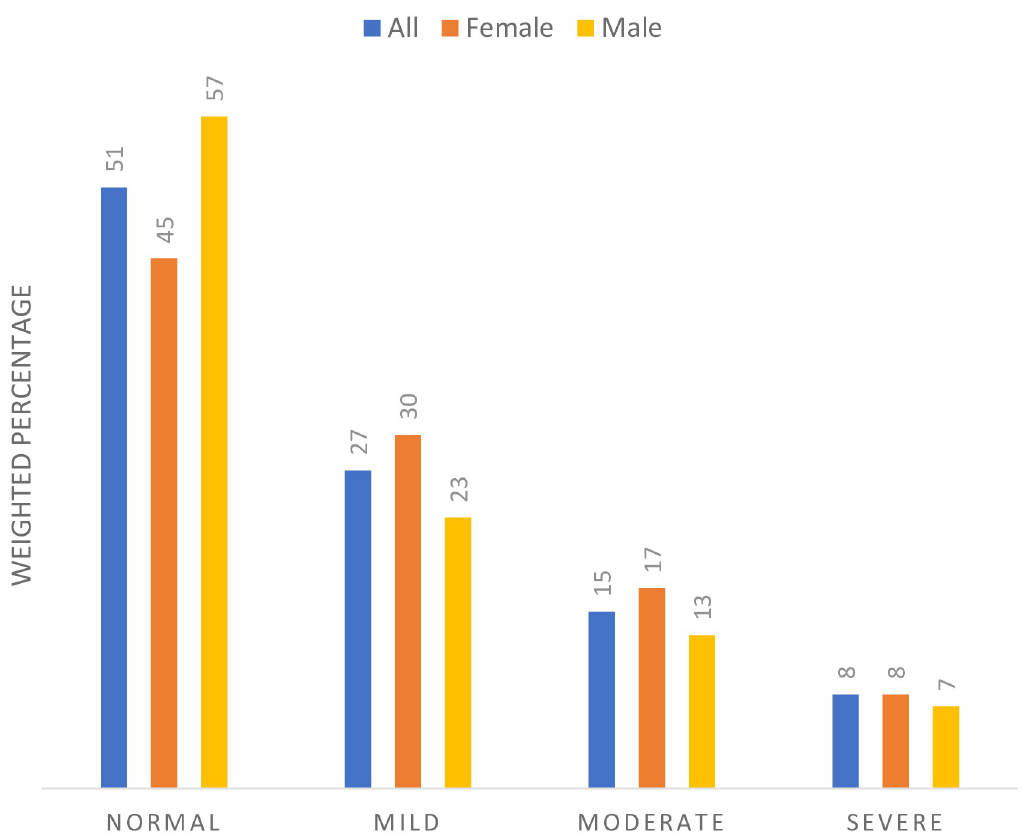
Fig 2. Distribution of psychological distress among respondents and across